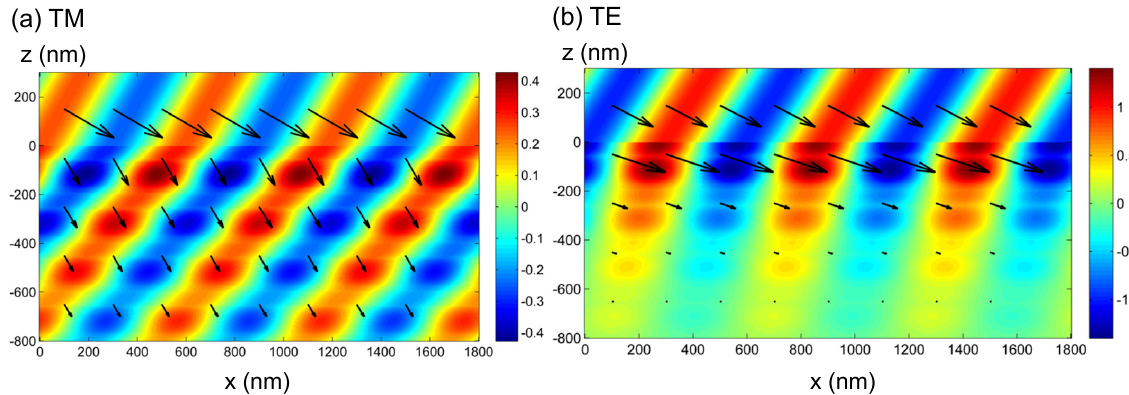
Figure 5. Illumination of the SMIM of the six-layer unit cell. ( a , b ) Electromagnetic (EM)-field distributions (color plots) at TM and TE polarizations, respectively. Specifically, the color plots represent snapshots of (a) H wavelength was 510.0 nm, and the incident angle was set to 60 ◦ . Arrows denote Poynting vectors in the xz plane.